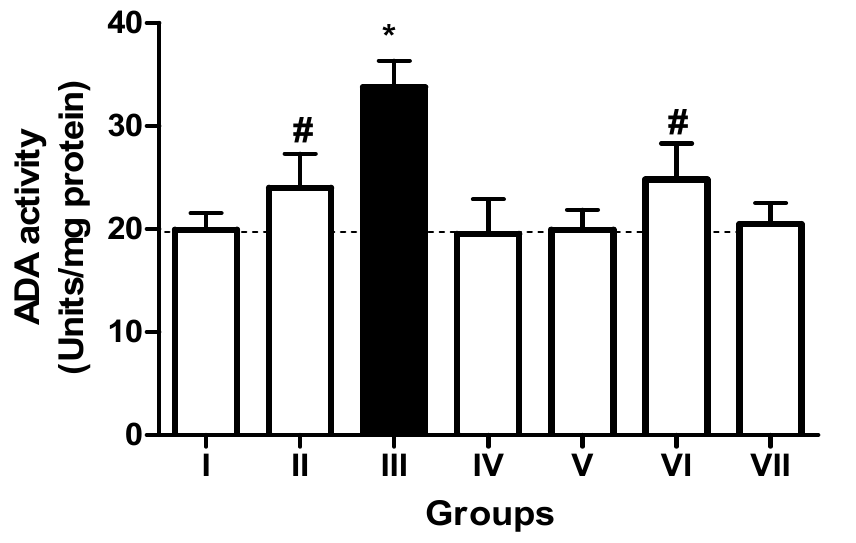
Figure 4. Adenosine deaminase (ADA) activity in platelets of L-NAME-stressed rats treated with tiger nut and walnut supplemented diets. Data are presented as mean ± SEM ( n = 10). The bars with various symbols are statistically different ( p < 0.05). * represents a significant difference from the control (I) group. # represents a significant difference from the ED (III) group (one-way ANOVA with